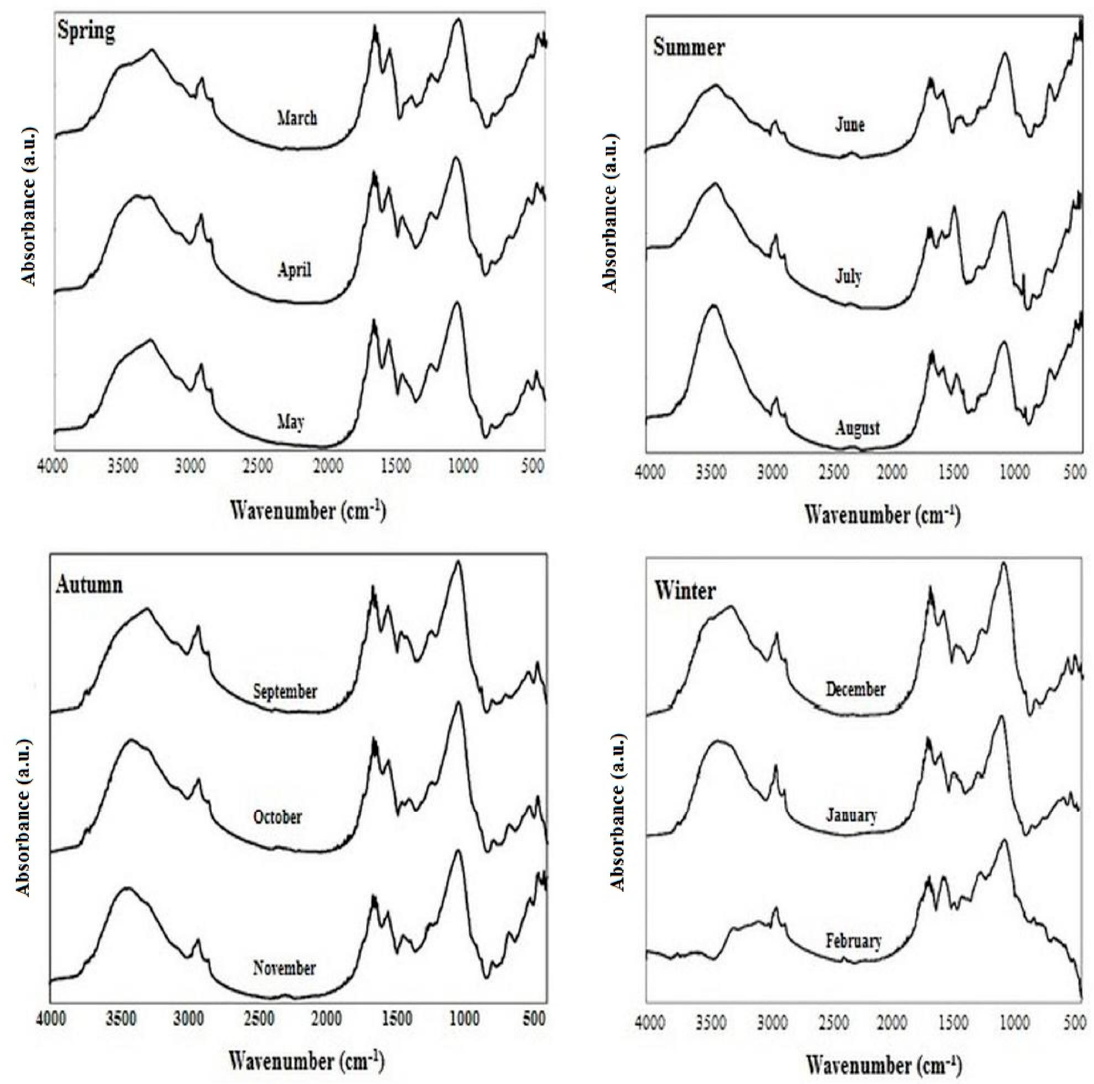
Figure 2. FTIR spectra of biosolids collected and evaluated in the UWWTP during different season of the year.